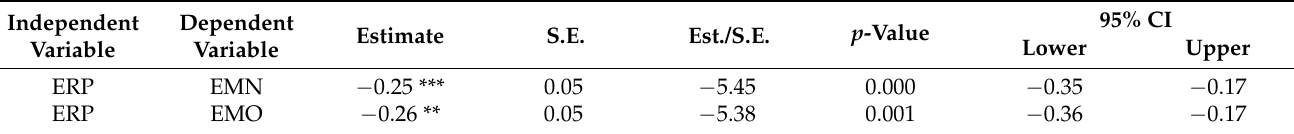
Table 5. The Mediating Role of Entrepreneurial